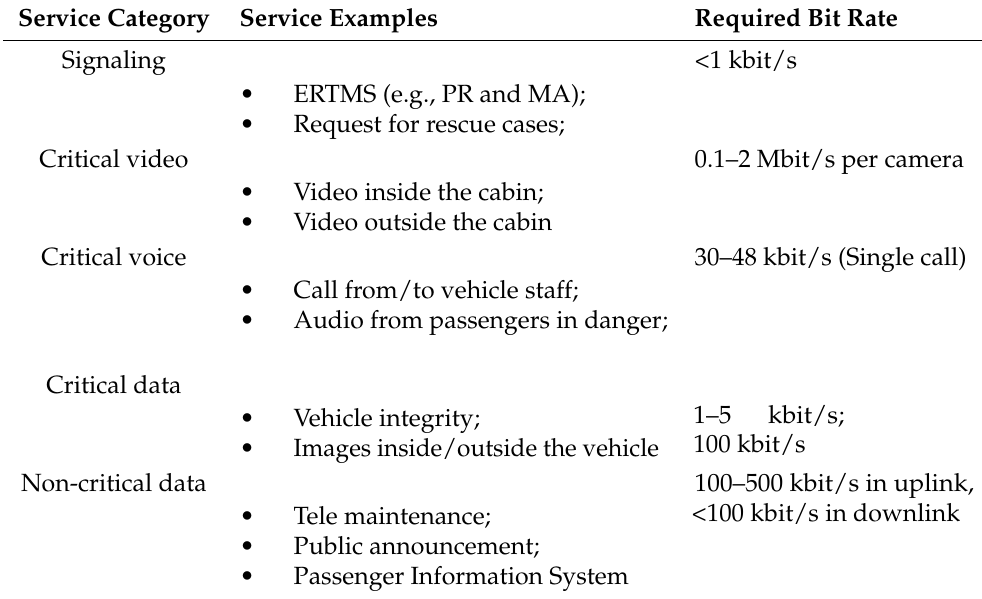
Table 1. Services and requirements for the rail case [11]. Service